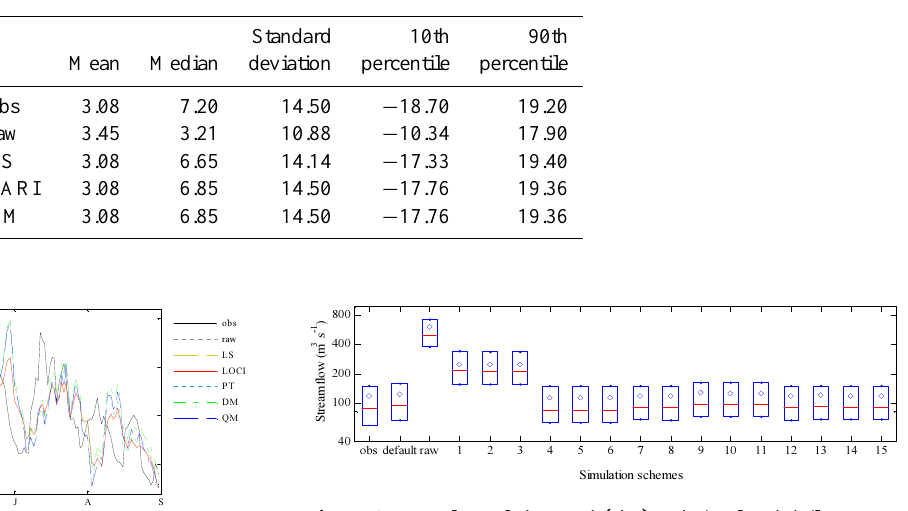
Figure 6. Box plots of observed (obs) and simulated daily stream- flows using observed (default), raw RCM-simulated (raw) and cor- rected meteorological data (setup of simulations 1–15 are listed in Table 3). The mean values are shown with